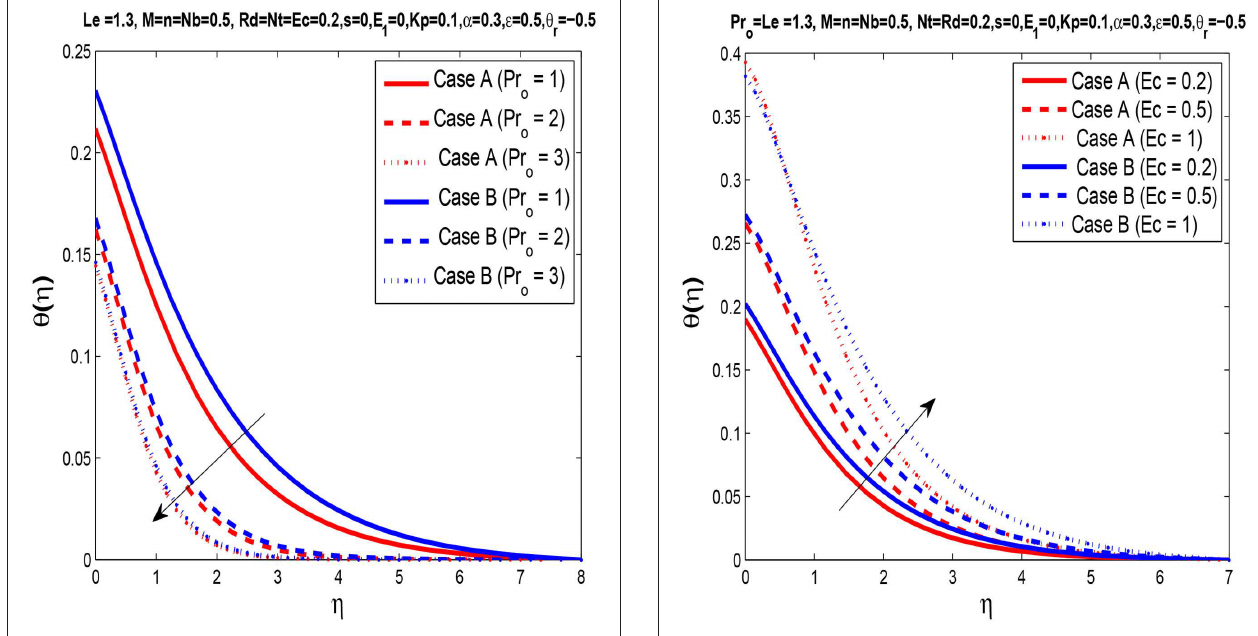
FIGURE 9 | Temperature profile θ ( η ) for different values of Ec